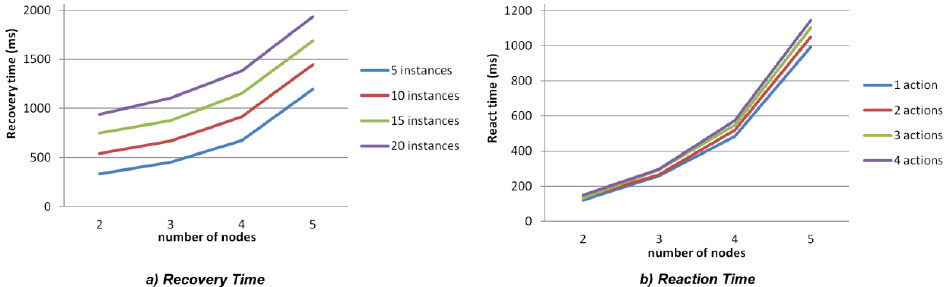
Figure 13. ( a ) Availability metrics: recovery time; ( b ) Adaptability metrics: reaction time.